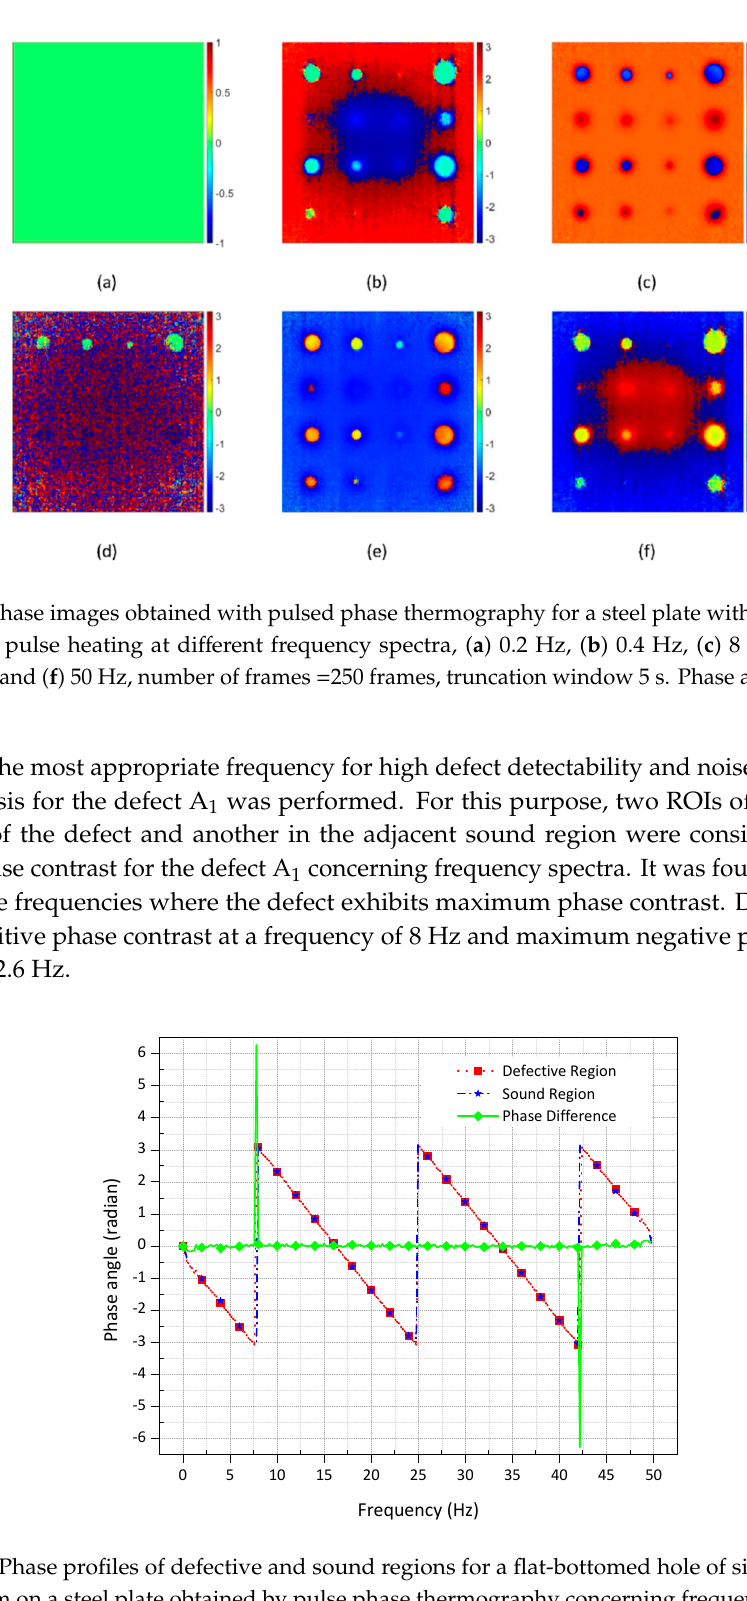
Figure 10. Phase profiles of defective and sound regions for a flat-bottomed hole of size 16 mm and depth 2 mm on a steel plate obtained by pulse phase thermography concerning frequency; frequency rate = 50 Hz, number of frames = 250 frames, truncation window 5 s.